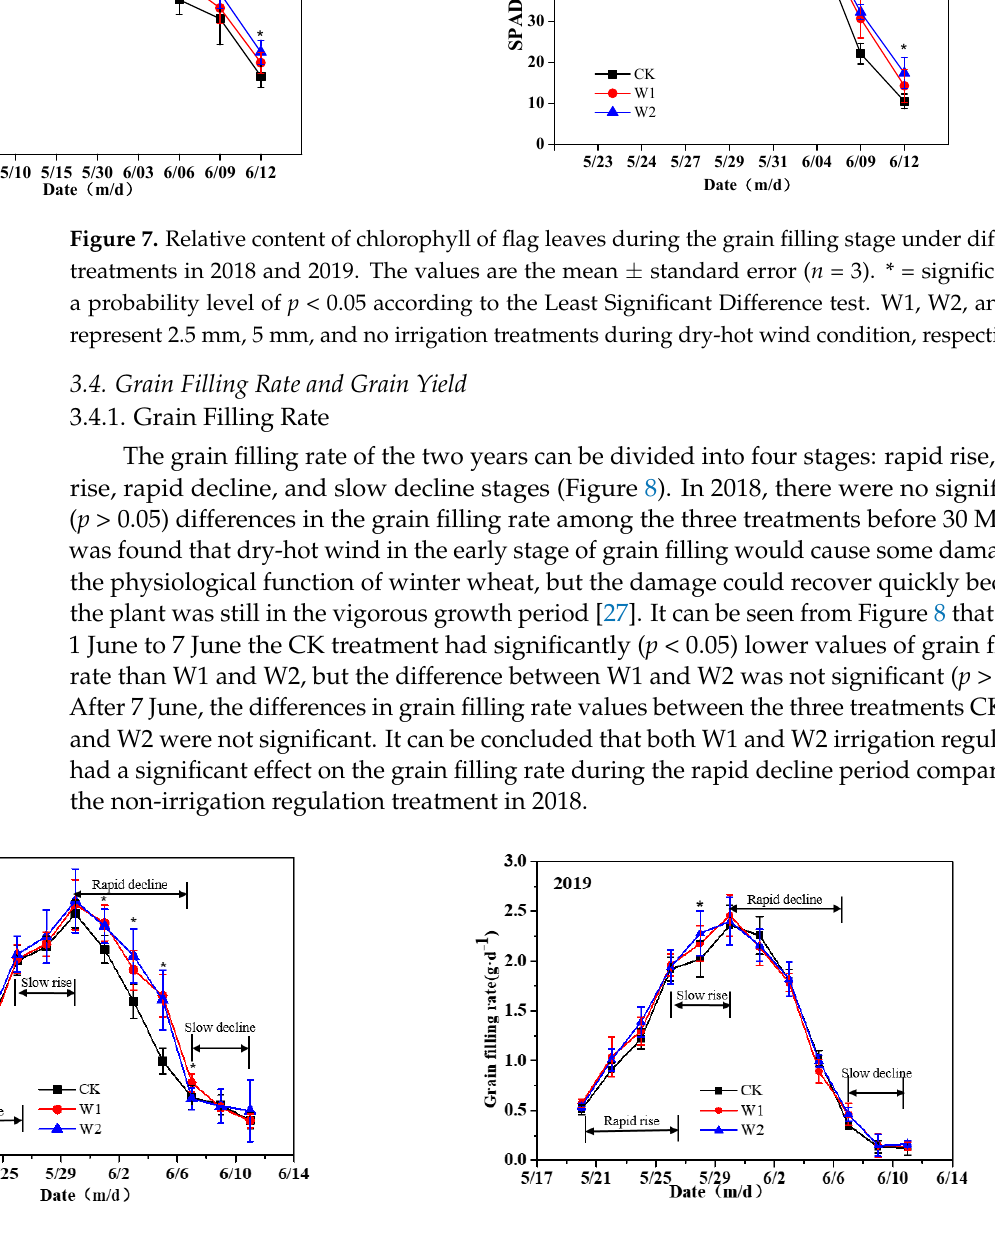
Figure 7. Relative content of chlorophyll of flag leaves during the grain filling stage under different treatments in 2018 and 2019. The values are the mean ± standard error ( n = 3). * = significant at a probability level of p < 0.05 according to the Least Significant Difference test. W1, W2, and CK rep- resent 2.5 mm, 5 mm, and no irrigation treatments during dry-hot wind condition, respectively.